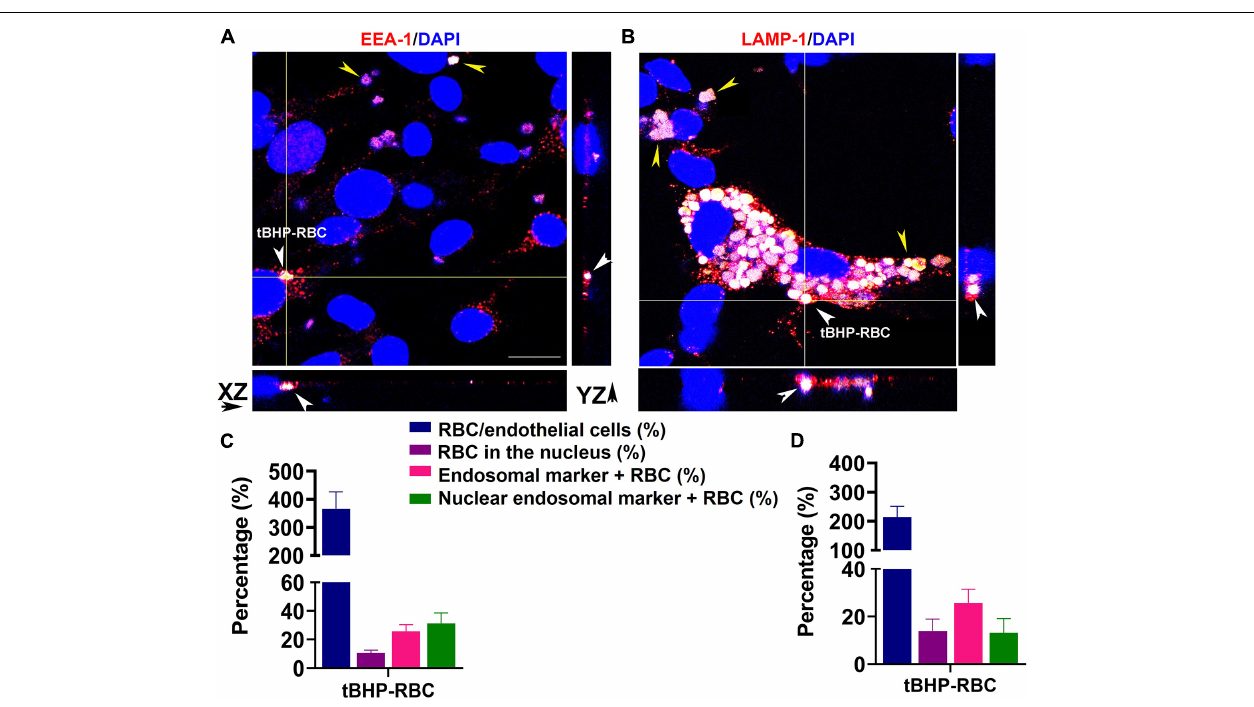
FIGURE 5 | A subset of tBHP-RBCs localized to early and late endosomes. bEnd.3 cells were stained for early endosome antigen 1 (EEA-1; red) (A) , lysosome–associated membrane protein 1 (LAMP-1; red) (B) , and 4 (cid:48) ,6-diamidino-2-phenylindole (DAPI; blue) after a 48-h incubation with PBS- or tBHP-RBCs. RBCs are indicated by yellow arrowheads in panels (A,B) . Massive accumulation of tBHP-RBCs within bEnd.3 cells is shown in panel (B) . Orthogonal projections from z-stacks of confocal images show tBHP-RBCs co-localized with the endosomal markers in bEnd.3 cells (white arrowheads in A,B ). Scale bar = 20 µ m. Quantification of RBC attachment (expressed as % of number of bEnd.3 cells), RBCs localized to the nucleus (expressed as % of total RBCs; also see Supplementary Figure 2 ), EEA-1- and LAMP-1-positive RBCs (expressed as % of total RBCs), and RBCs in the nucleus positive for EEA-1-/LAMP-1 (expressed as a % of RBCs in the nucleus) (EEA-1: C and LAMP-1: D ). All experiments were repeated at least three